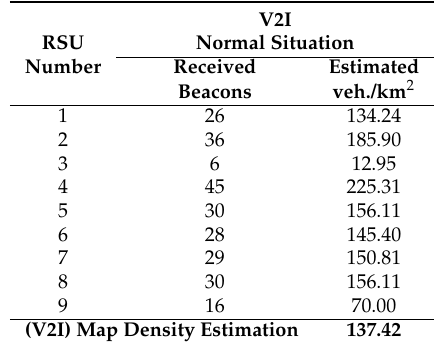
Table 8. V2I-based estimated vehicle density when simulating 150 vehicles/km 2 in San Francisco under normal conditions. RSU, road side unit.